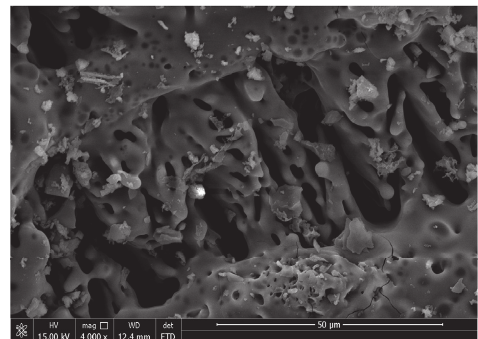
Figure 16: Raw rice husk ash of being magnified 4000